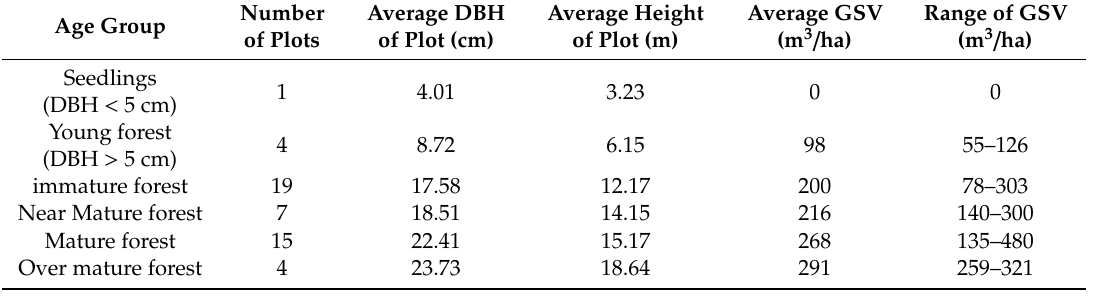
Table 2. Statistical parameters of stand variables for the ground measured plots.